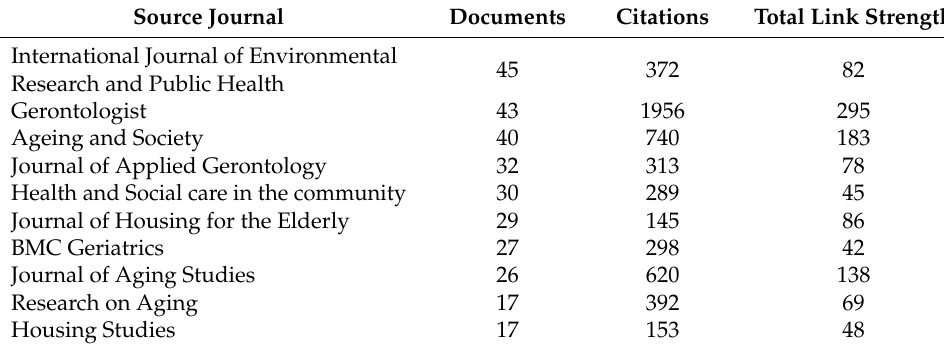
Figure 6: Network visualization of journal co-citations